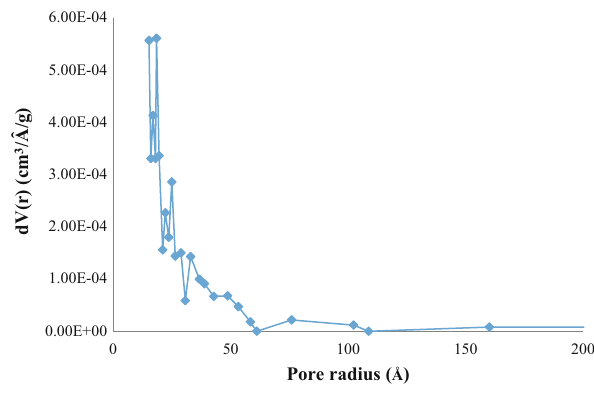
Figure 12: Graph of MIL - 100 ( Al ) pore distribution.